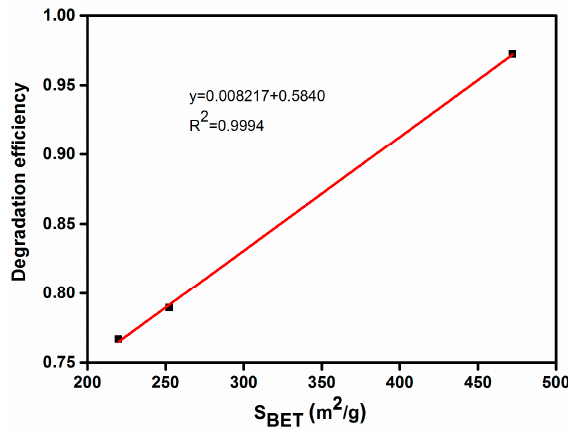
Figure 12. Correlation curve between BET surface area of Ag-N-ZnO/CHAC, Ag-N-ZnO/CAC and Ag-N-ZnO/AAC and remove efficiency of MO.